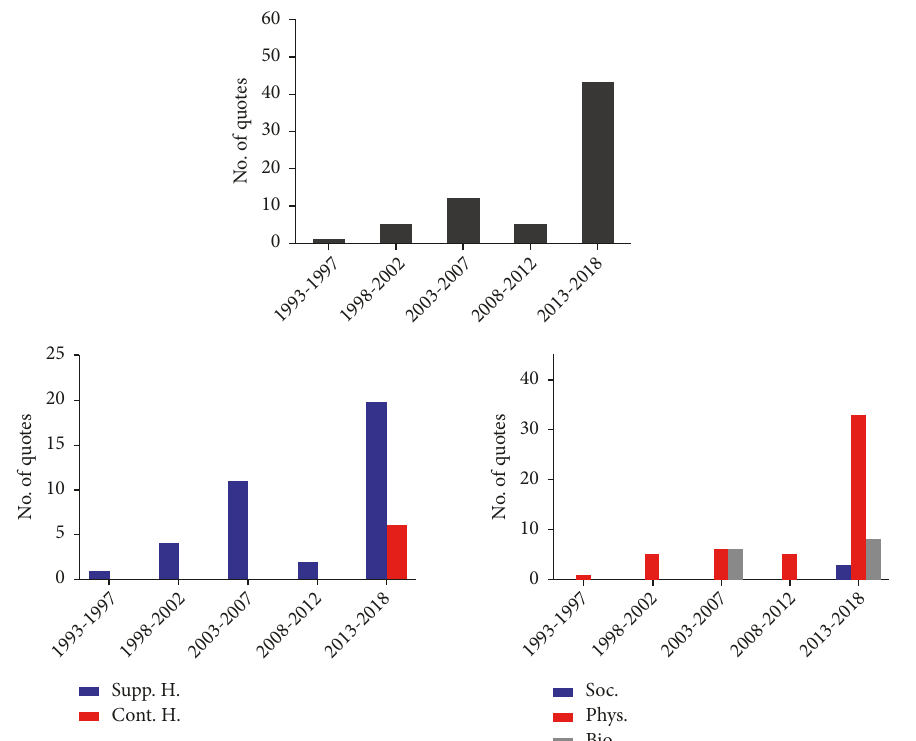
Figure 6: Visualising temporal analyses on quotes that include the term herding. The column chart on the top represents the total number of quotes and the ones in the bottom splits the frequency based on whether the quotes support or contradict the theory (chart on the left) and based on the study discipline (chart on the right). To account for the fact that the last time interval includes 6 years as opposed to the rest of the time intervals that include 5 years, the numbers associated with the last interval have been scaled down by a factor of 5/6. The very few studies covered by this review and published prior to 1993 or in 2019 we accommodated in the first and last intervals,